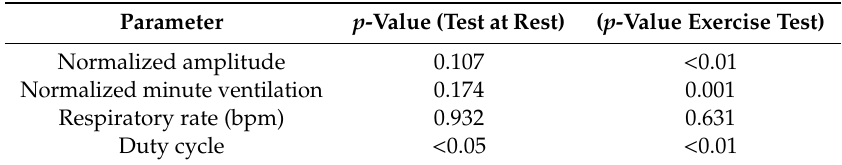
Table 4. p-values of the tests at rest (all di ff erent positions) and of the exercise tests (all di ff erent intensities) obtained from the One Way Kruskal–Wallis test.